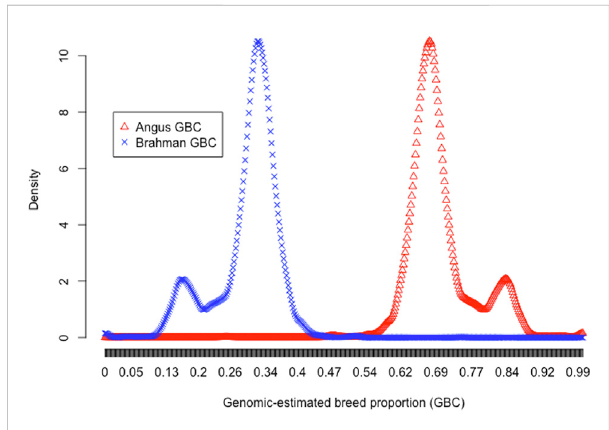
FIGURE 1 Density plots of genomic-estimated Angus (red triangle) and Brahman (blue cross) breed compositions for 3,605 Brangus